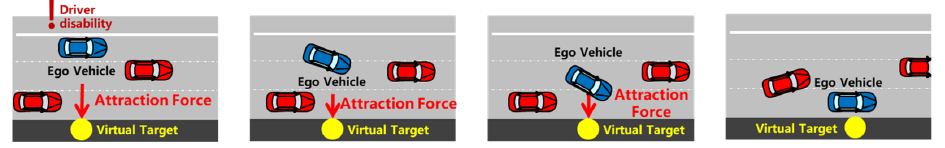
Figure 5. Concept of virtual target attraction.